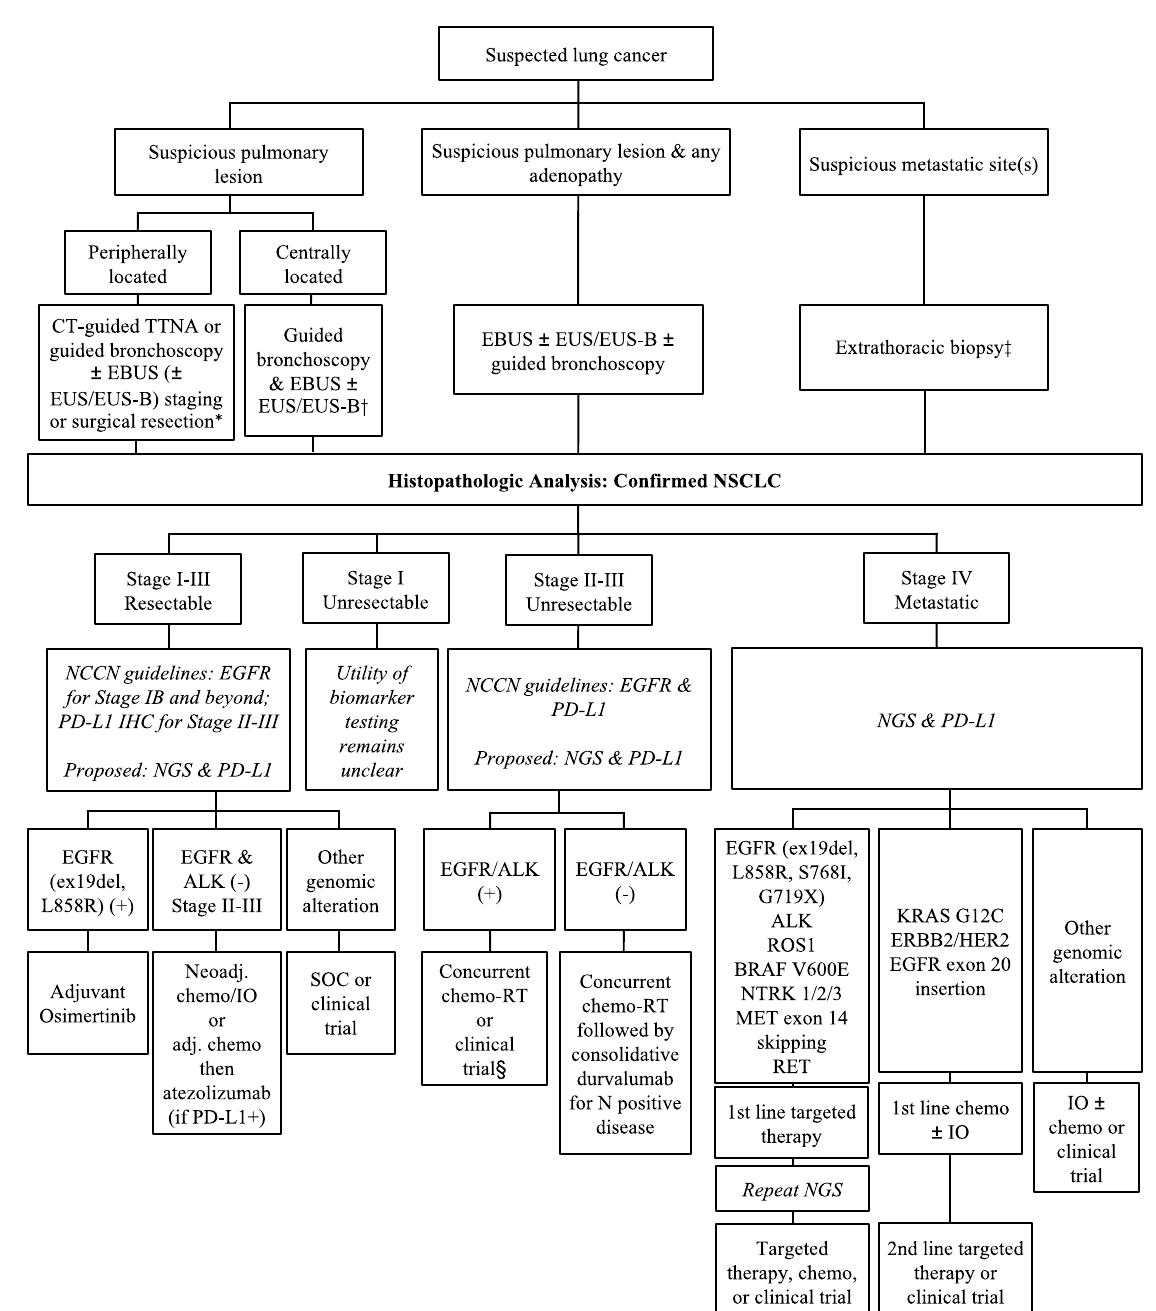
Figure 2. Approach to tissue biopsy and biomarker testing and treatment in NSCLC by disease stage. IO = immunotherapy; SOC = standard of care. * The utility of routine mediastinal and hilar